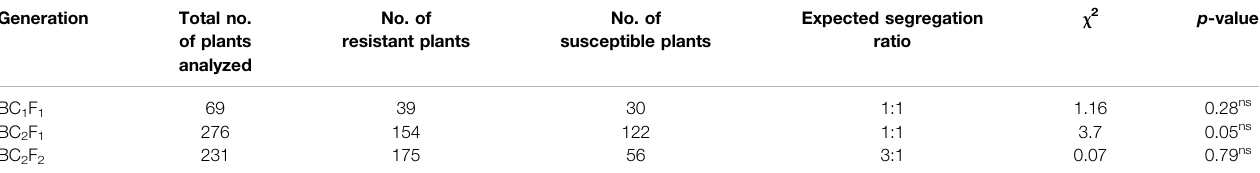
TABLE 1 | Genetic analysis of root-knot nematode resistance in different generations derived from the cross of PR121 (S) and O. glaberrima acc. IRGC102206 (R). Generation